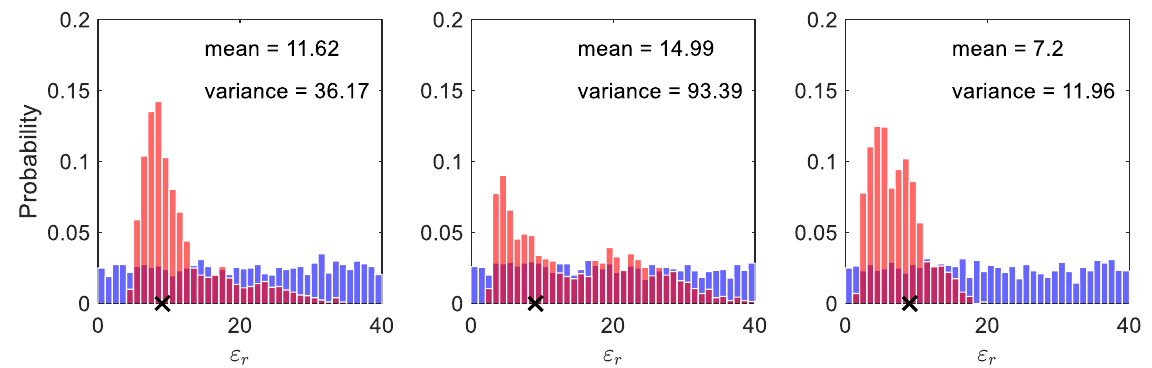
Figure 2. Histograms of the prior (blue bars) and posterior (red bars) distribution of three randomly selected parameters derived from Bayesian inversion using the straight-ray forward model with first-arrival traveltime data. The true values of the parameters are denoted with black crosses.